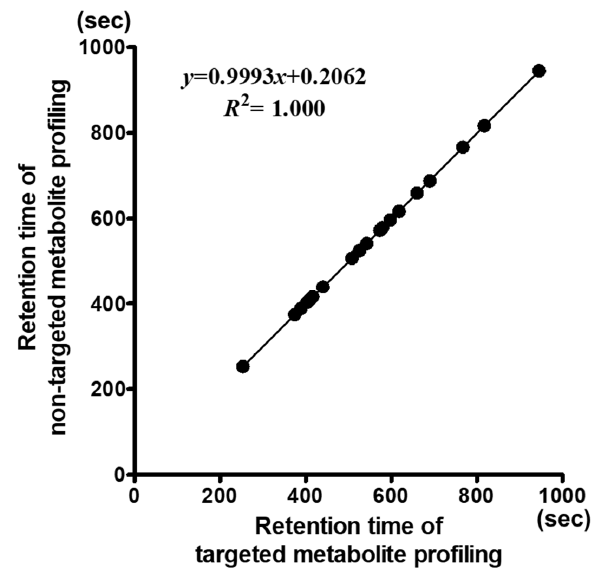
Figure 1. Analytical ion chromatograms of K5 adzuki bean samples obtained using non-targeted (A) and targeted (B) metabolite profiling with gas chromatography (GC)– time-of-flight (TOF) mass spectrometry (MS).